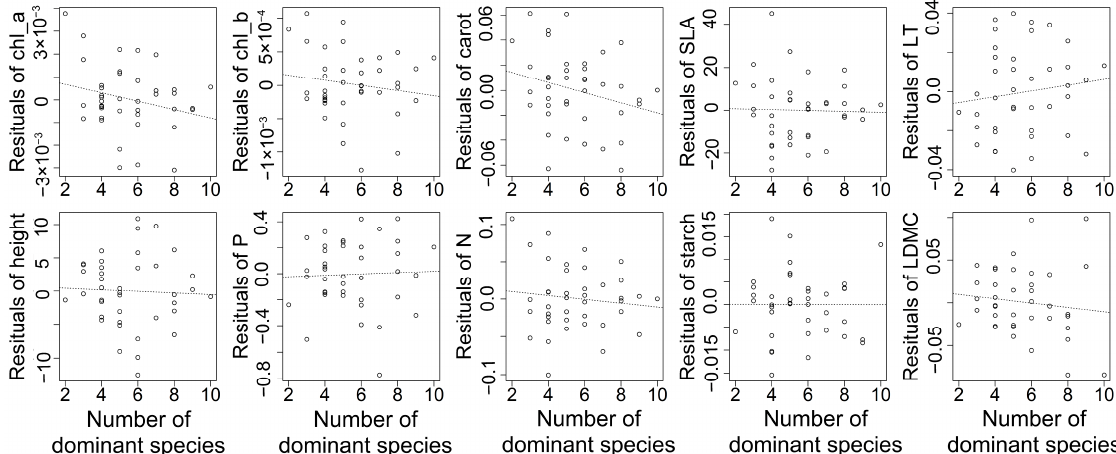
Figure 5. Relationships between the predicted residuals of plant community traits and the number of dominant species in each plot. Dotted lines denote non-significant relationships ( p > 0.05): chl_a, chlorophyll a ; chl_b, chlorophyll b ; carot, carotenoid; SLA, specific leaf area; LT, leaf thickness; height, plant height; P, phosphorus content; N, nitrogen content; starch, starch content; LDMC, leaf dry matter content.